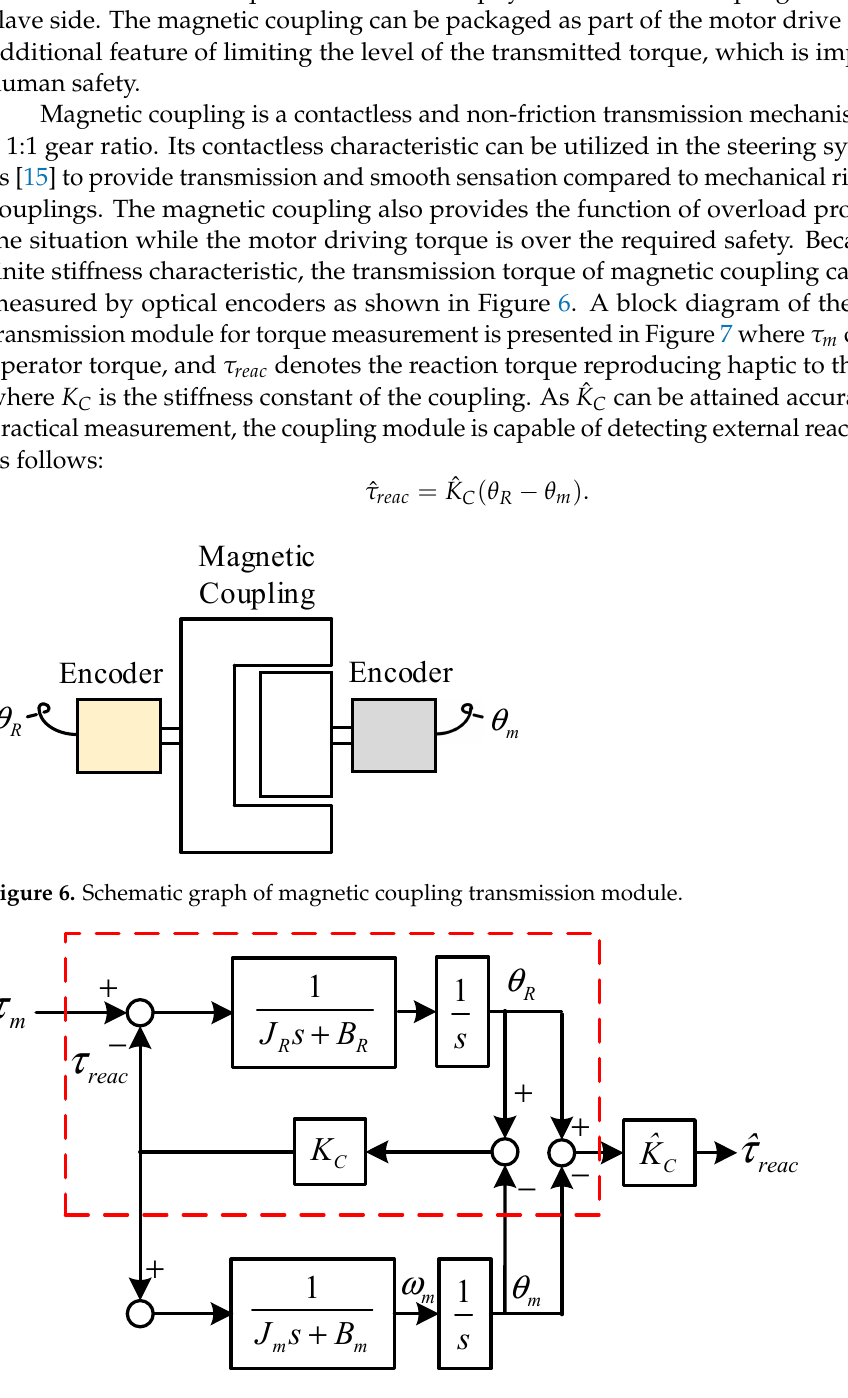
Figure 7. Block diagram of magnetic coupling transmission module.